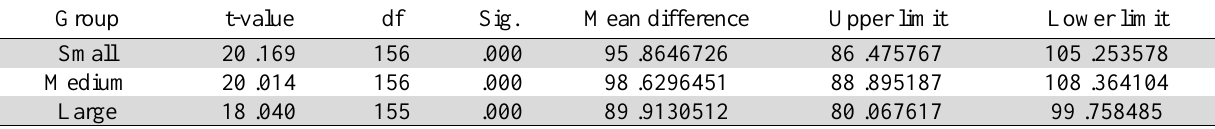
The summary of t-student test among different pairs of observations